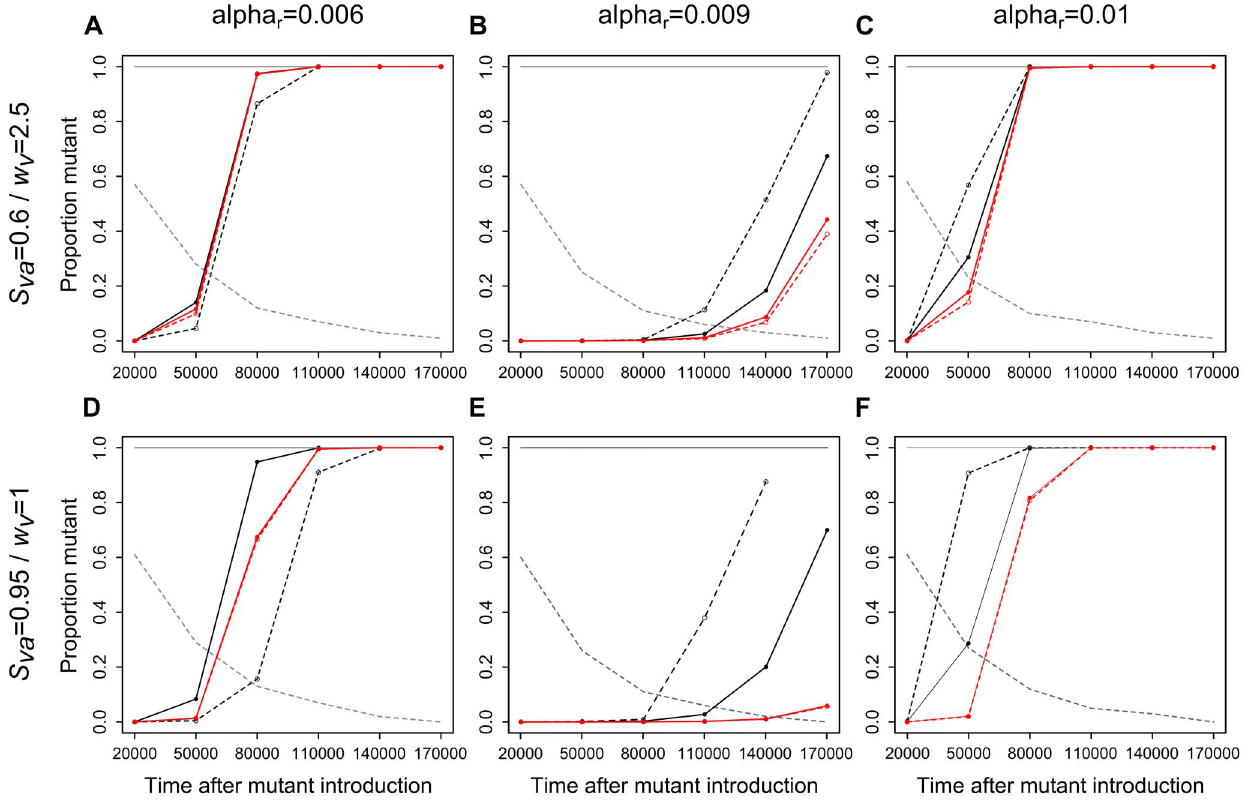
Figure 3. Dynamics of mutant invasion (proportion of mutants among infections according to time after mutant introduction). Proportion of the mutant is calculated as the number of hosts infected by the mutant parasite divided by the total number of infected hosts, and given as a median among all simulations for which the vector density did not collapse at the simulation time considered. Red and black lines correspond, respectively, to results in the deterministic and stochastic case (grey lines: persistence probability of vector populations); solid lines (solid circles) and dashed lines (open circles) to a relatively efficient and less efficient risk-spreading strategy. Panels a, b, c: S va =0.6, w v =2.5, less efficient risk-spreading strategy: P j =0.3, more efficient: P j =0.8; panels d, e, f: S va =0.95, w v =1, less efficient risk-spreading strategy: P j =0.4, more efficient: P j =0.8. Other parameters values are: b =0.005, c =0.01, S hs =0.994, w h =0.05, g =100, q =50, b max =1, r =0.5, p b =0.2, e S =0.1, S vj =0.95, a m =0.008.